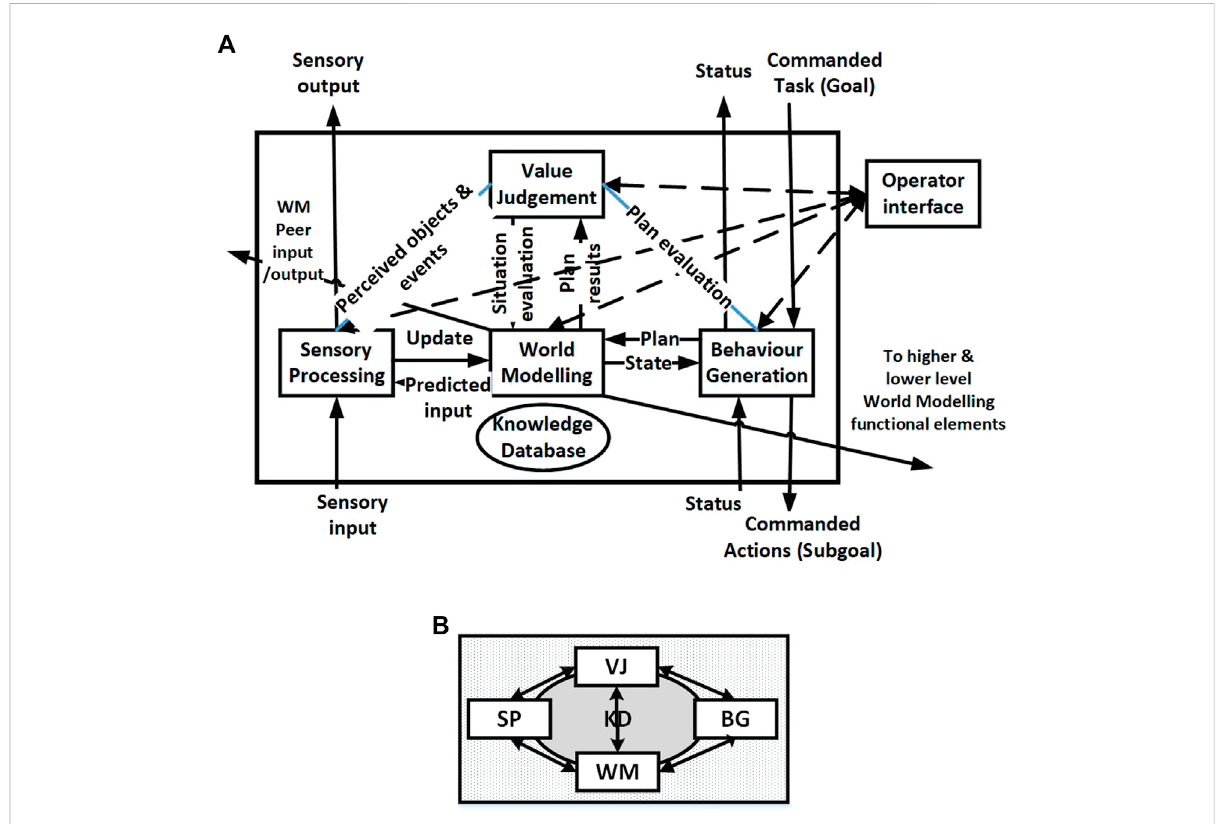
Figure 2B is a schematic representation of its principle